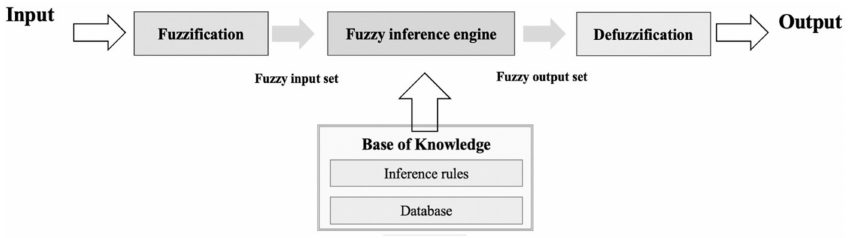
Figure 3. The main structure of a fuzzy inference system